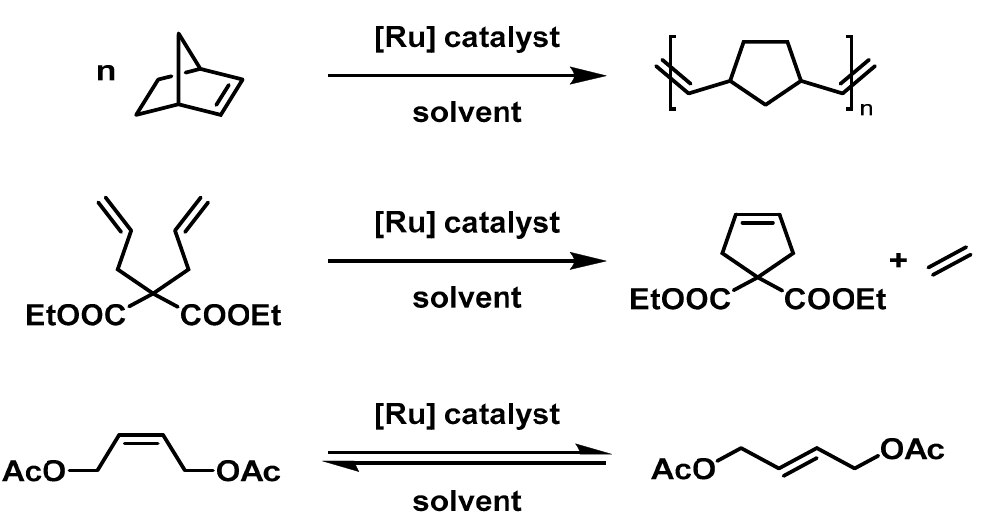
Scheme 1. Ring-opening metathesis polymerization (ROMP) of norbornene (top),